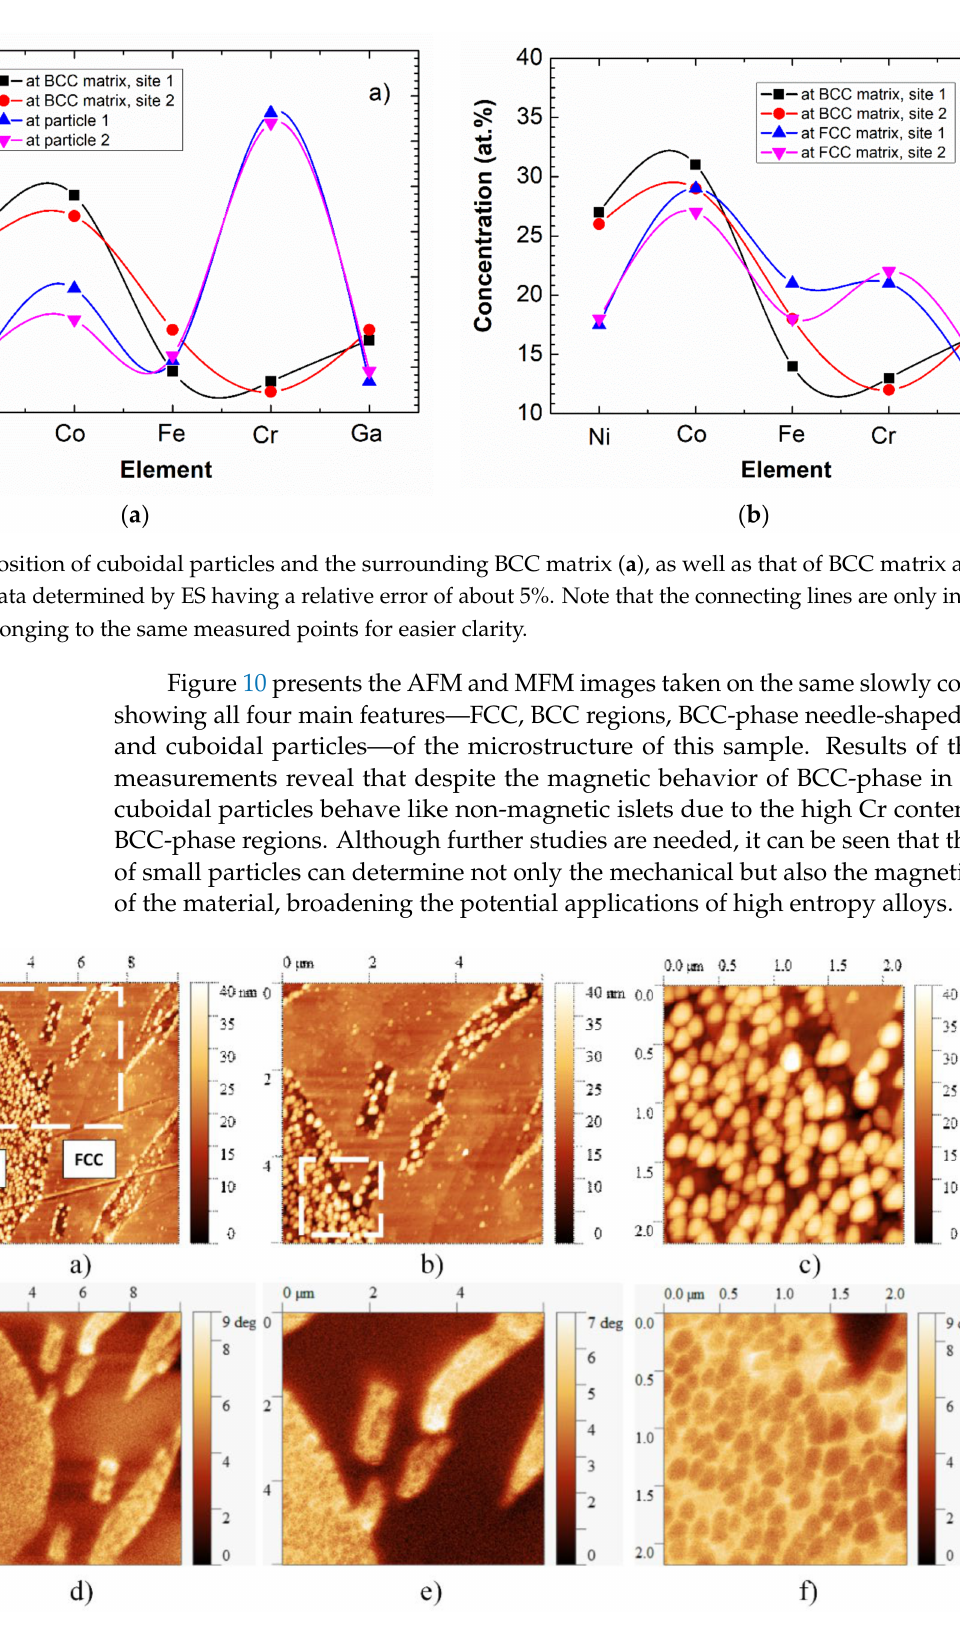
Figure 10. AFM ( a – c ) and corresponding MFM images ( d – f ) taken at different magnifications on the microstructure of the sample heat-treated at 1150 K for 1 h and slowly cooled. On the MFM image, the brighter color represents the higher magnetic property. Despite the magnetic behavior of the BCC phase, the cuboidal particles behave like non-magnetic regions due to the high Cr